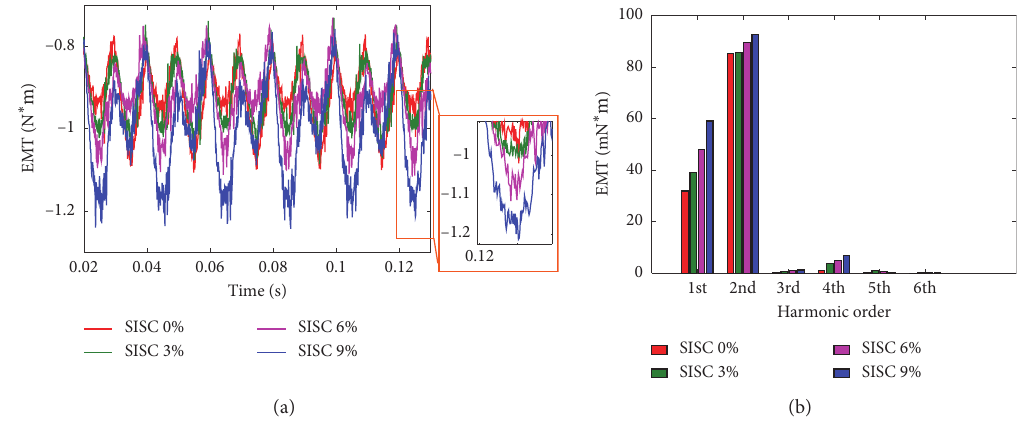
Figure 10: Experimental data of EMT under different SISC degrees: (a) time-domain waveform and (b)